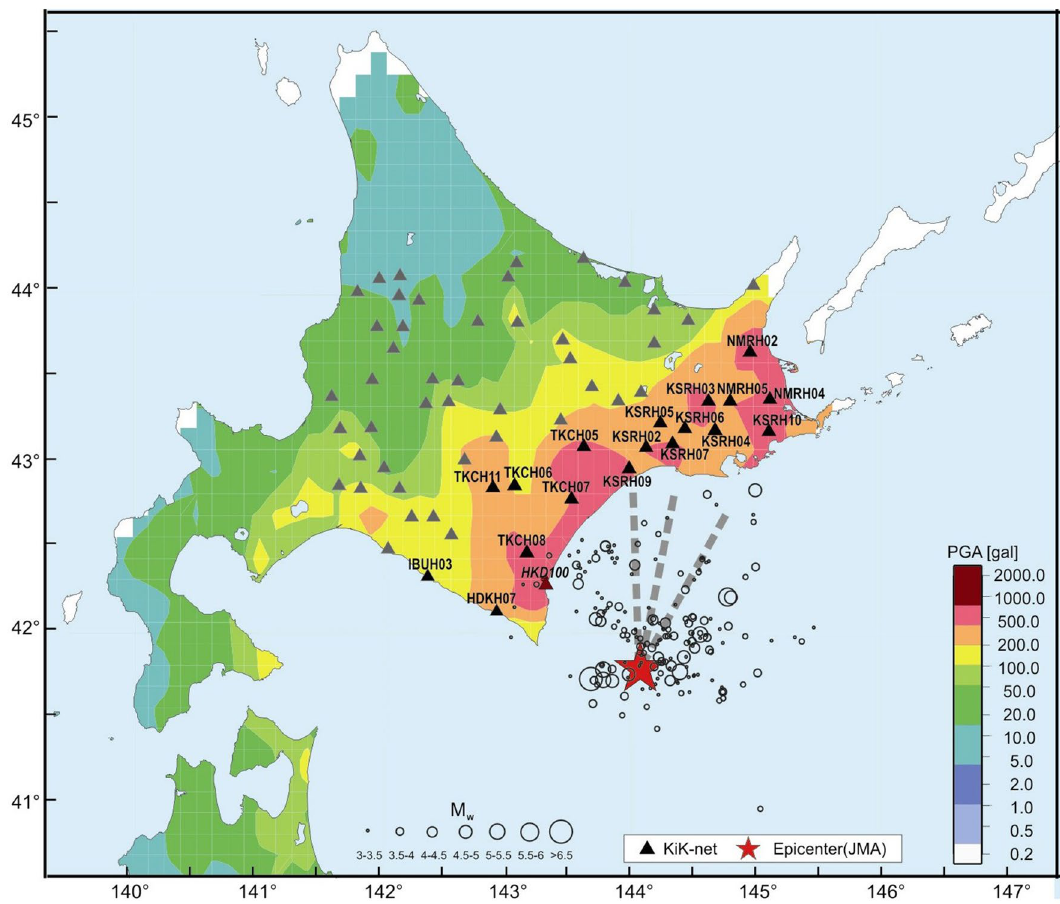
Figure 1. Map showing the distribution of PGA recorded during the 2003 Tokachi-oki earthquake (NIED data 21 ), locations of the main shock (star), aftershocks (circles) ( M w > 3) recorded in 24 h after the main shock (JMA data), and KiK-net stations (triangles). The dotted lines show horizontal projections of the rupture propagation towards KSRH09, KSRH06, and KSRH10